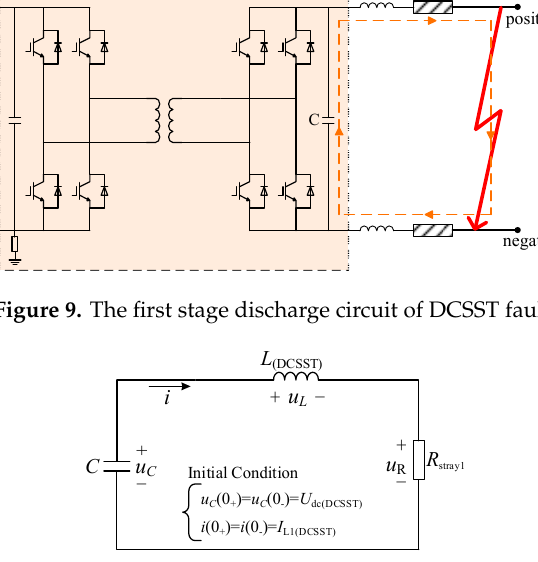
Figure 10. Equivalent circuit of the first stage discharge circuit of DCSST.